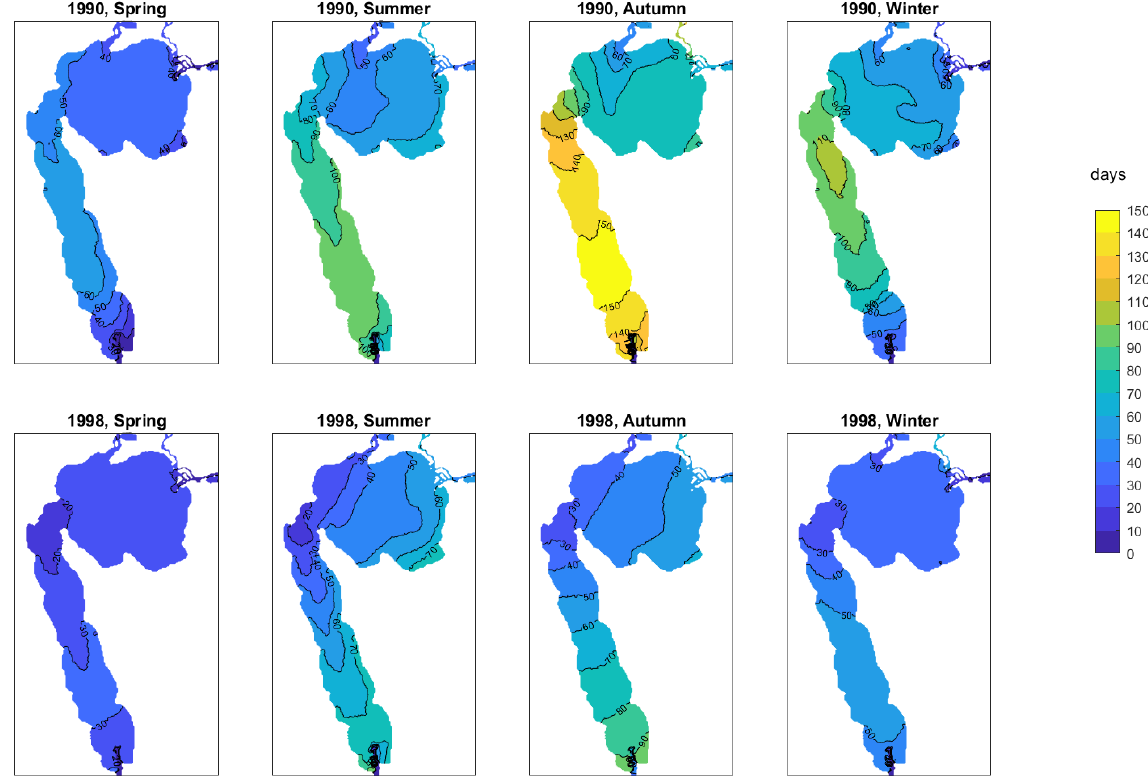
Figure 9. Spatial distribution of season-averaged water age in 1990 (top panels) and 1998 (bottom panels).